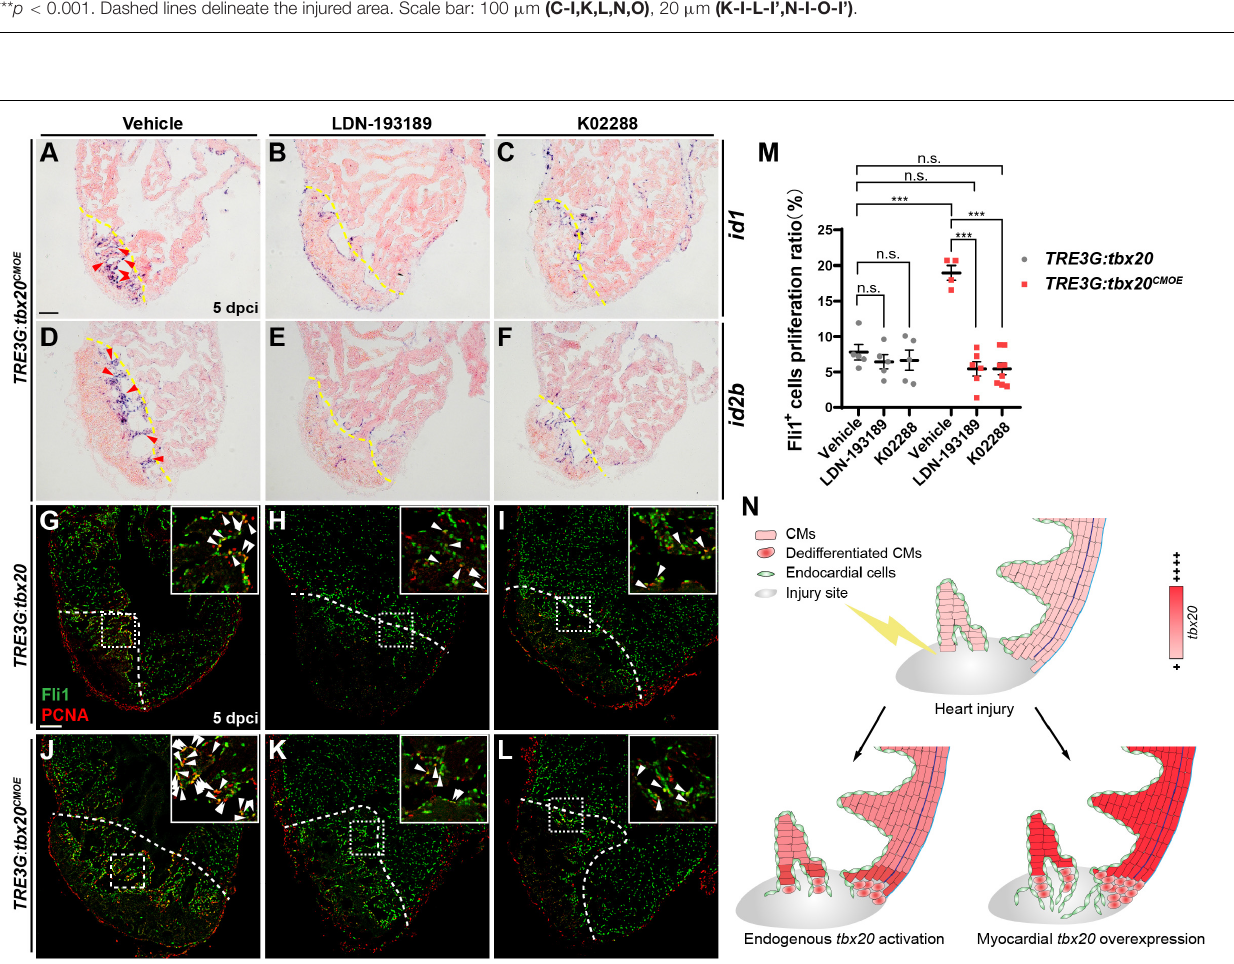
FIGURE 6 | Myocardial Tbx20 mediates endocardial regeneration by activating Bmp6 signaling. (A,B) Myocardial tbx20 overexpression upregulates BMP target genes id1 and id2b as well as the BMP ligand bmp6 after heart resection (A) or cryoinjury (B) , respectively. Data from three biological replicates. Mean ± SEM, ** p < 0.01, *** p < 0.001. (C–E) Representative ISH images of heart sections from DOX-treated uninjured Tg ( TRE3G:tbx20 ) (C) , 5 dpci Tg ( TRE3G:tbx20 ) (D) and Tg ( TRE3G:tbx20 CMOE ) zebrafish (E,E’) with bmp6 probe. Red arrowheads indicate endocardium with bmp6 signal. (F–I) Representative ISH images of heart sections from 5 dpci DOX treated Tg ( TRE3G:tbx20 ) and Tg ( TRE3G:tbx20 CMOE ) fish with id1 (F,G) and id2b (H,I) probe. Red arrowheads indicate endocardium with id1 (G’) and id2b (I’) signal in the injury site. (J) Experimental procedures for DOX treatment, cryoinjury, FISH combined with immunostaining experiments. (K,L) Representative images of FISH analysis of bmp6 (red) combined with immunostaining for GFP and α -actinin (blue) on heart sections from 5 dpci Tg ( TRE3G:tbx20;flk:GFP ) (K) and Tg ( TRE3G:tbx20 CMOE ;flk:GFP ) (L) zebrafish. Boxed areas indicate locations of the magnified and channel-separated panels below. White arrowheads point to GFP + cells with bmp6 transcripts in border zone and injury site (K-I,K-I’,L-I,L-I’) , yellow arrows in (L-I) and (L-I’) indicate non-endocardial cells with bmp6 transcripts. (M) Dotted diagram indicates the percentage of bmp6 + endocardial cells in injury site from 5 dpci DOX treated Tg ( TRE3G:tbx20 ) ( K , n = 5) and Tg ( TRE3G:tbx20 CMOE ) ( L , n = 6) fish. Mean ± SEM, *** p < 0.001. (N,O) Representative images of FISH analysis of id2b (red) combined with immunostaining for GFP and α -actinin (blue) on heart sections from 5 dpci Tg ( TRE3G:tbx20;flk:GFP ) (N) and Tg ( TRE3G:tbx20 CMOE ;flk:GFP ) zebrafish (O) . Boxed areas indicate locations of the magnified and channel-separated panels below. White arrowheads point to GFP + cells with id2b transcripts in border zone and injury site (N-I,N-I’,O-I,O-I’) , yellow arrows in (O-I) and (O-I’) indicate non-endocardial cells with id2b transcripts. (P) Dotted diagram indicates the